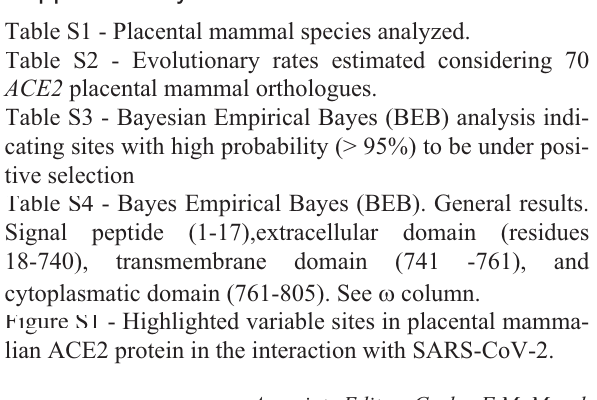
Figure S1 - Highlighted variable sites in placental mamma- lian ACE2 protein in the interaction with